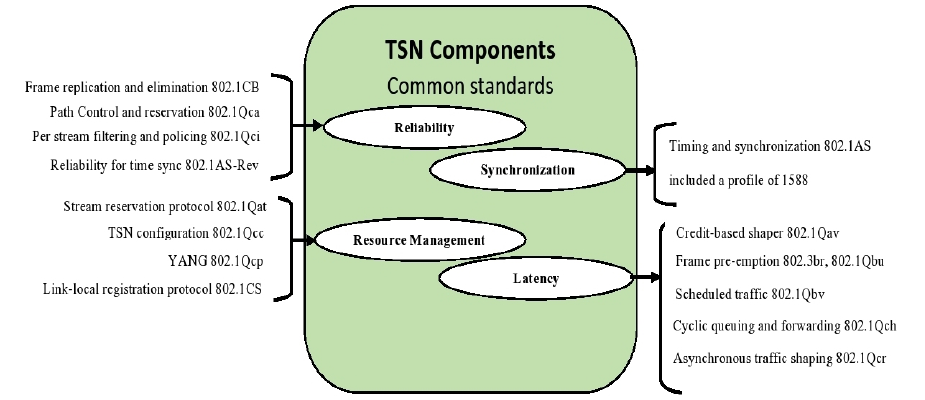
Figure 7. TSN common finalized standards [61].